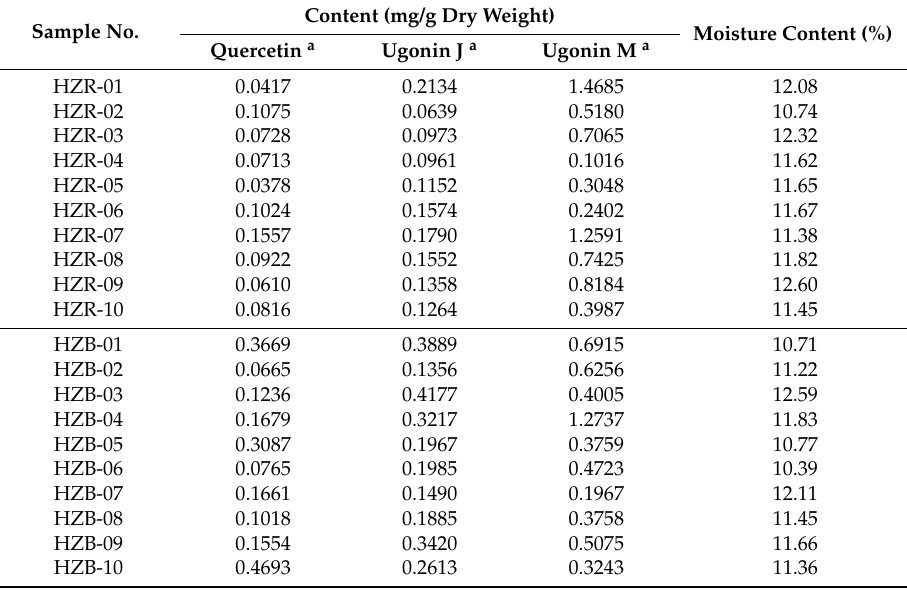
Table 3. Contents of three analytes in different HZ samples.